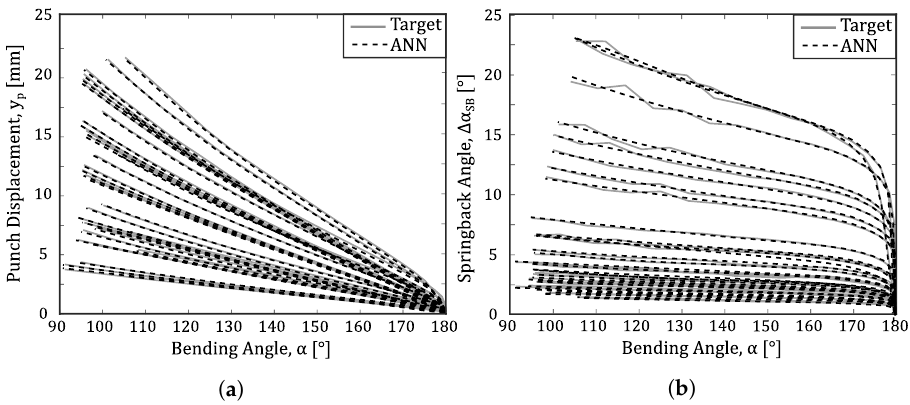
Figure 20. ( a ) Punch displacement ( y p ) graph and ( b ) springback angle ( ∆ α SB ) graph as a function of required bending angle ( α ) for the total V / t combinations used in problem